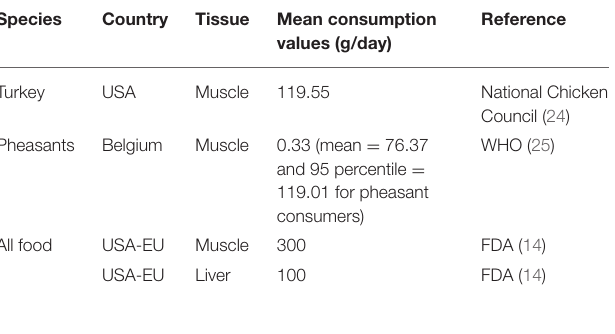
TABLE 2 | FDA liver tolerances, EMA liver MRLs, pheasant’s fenbendazole sulfone LODs and Japan, New Zealand, and Turkey duck liver tolerance for different tissues. Species Country/region